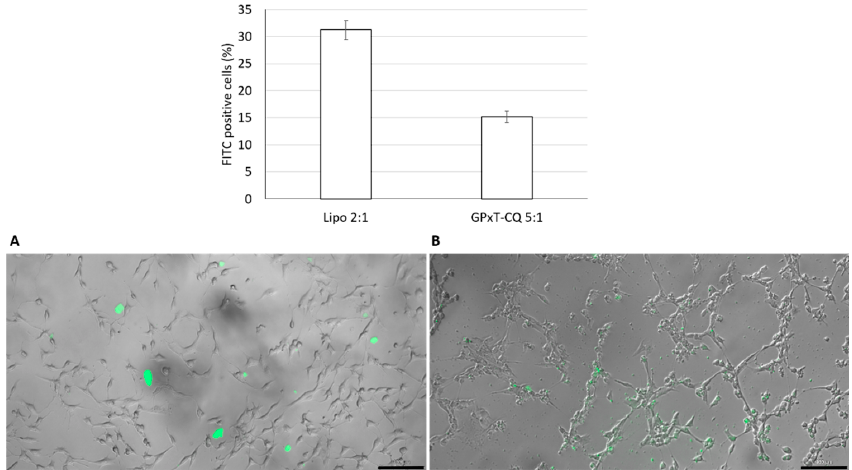
Figure 4. Uptake of FITC-labeled nioplexes in hUSC cells. Lipofectamine was added at a mass ratio of 2:1 and GPxT-CQ 5:1 ( w / w ). Upper panel: percentage of FITC-positive cells and viability. Data represent the mean ± SD ( n = 3). Lower panels: fluorescence micrographs of hUSC cells at 4 h of incubation with FITC-labeled nioplexes (Green). ( A ) Uptake of GPxT-CQ at a lipid/DNA ratio of 5:1 ( w / w). 1.25 µ g of DNA and 6.25 µ g of GPxT-CQ cationic niosome were added to each well; ( B ) uptake with Lipofectamine at a lipid/DNA ratio of 2:1 ( w / w ) used as a positive control. 1.25 µ g of the plasmid and 2.5 µ g lipofectamine were used. Scale bar: 100 µ m.